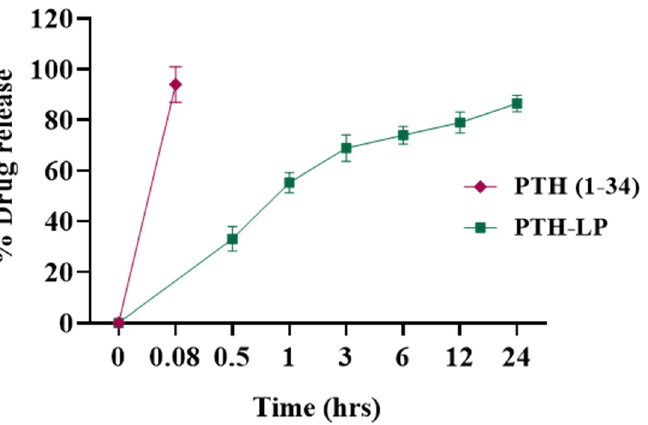
Figure 5. In vitro release profile of PTH (1-34) (red) and PTH (1-34) from PTH-LPs (green). Data represent the mean ± SD ( n = 3).